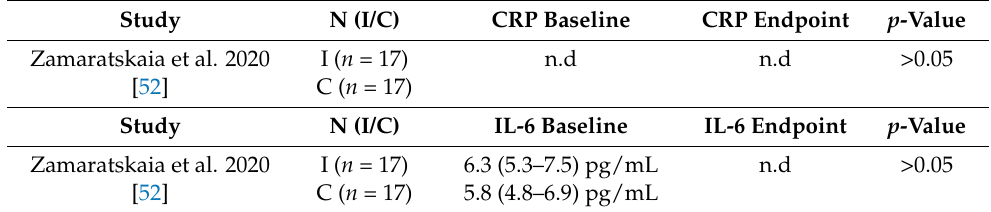
Table 5. Effect of whole grain consumption on inflammatory markers in individuals with other